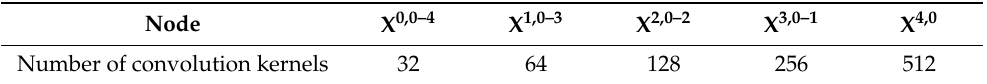
Table 2. Number of convolution kernels.